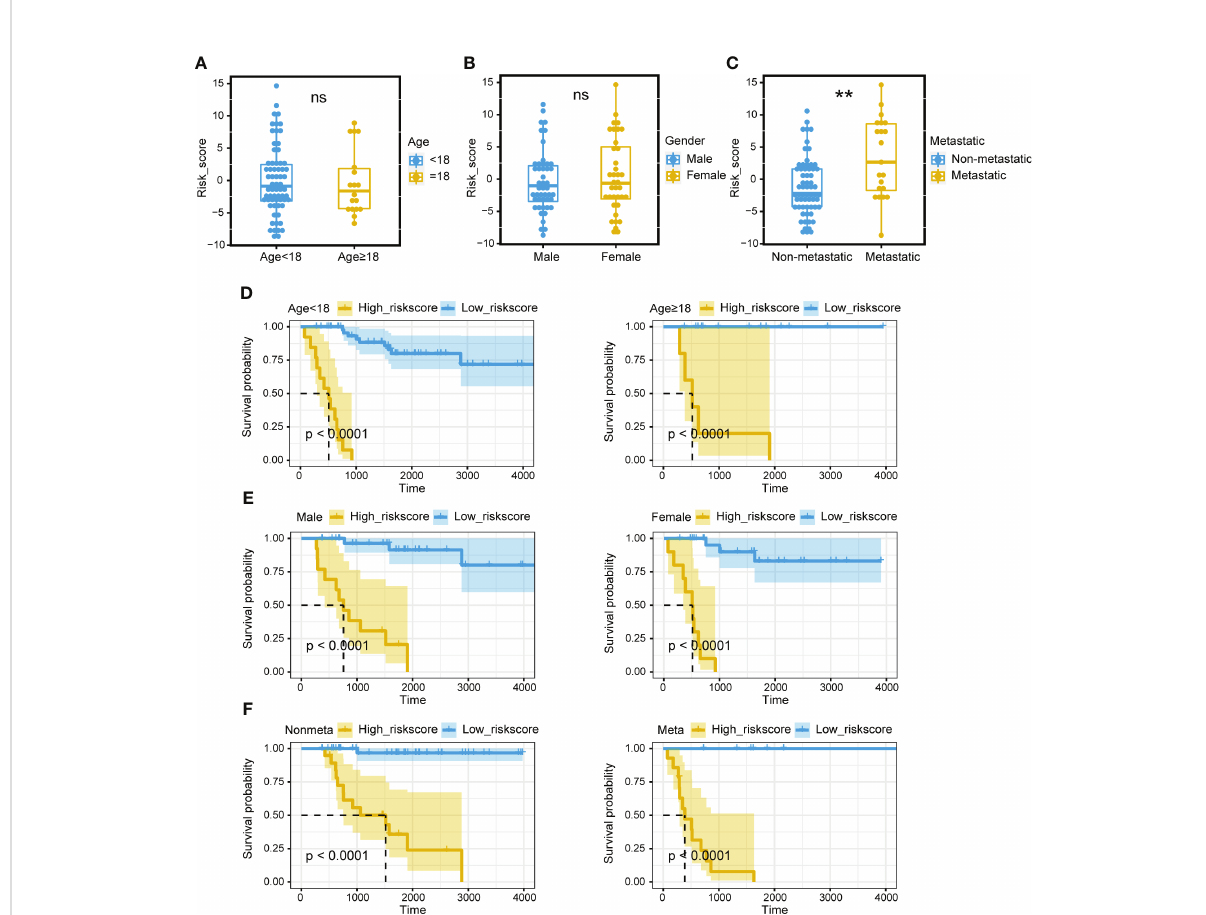
FIGURE 2 Prognostic value of the mitochondria-related signature. (A) The different levels of the mitochondria-related signature score regarding age. (B) The different levels of the mitochondria-related signature score regarding gender. (C) The different levels of the mitochondria-related signature score regarding metastasis. (D) Survival analysis was performed on the two mitochondria-related signature score groups regarding age in TARGET. (E) Survival analysis was performed on the two mitochondria-related signature score groups regarding gender in TARGET. (F) Survival analysis was performed on the two mitochondria-related signature score groups regarding metastasis in TARGET. ns, no signi fi cance; **p <